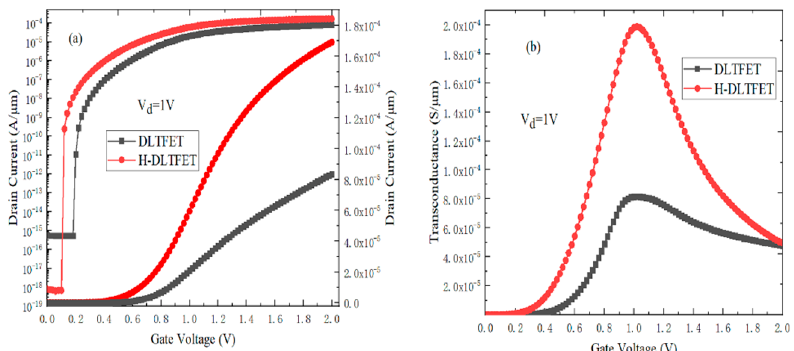
Figure 2. ( a ) Transfer characteristics; ( b ) transconductance of the DLTFET and the H-DLTFET.